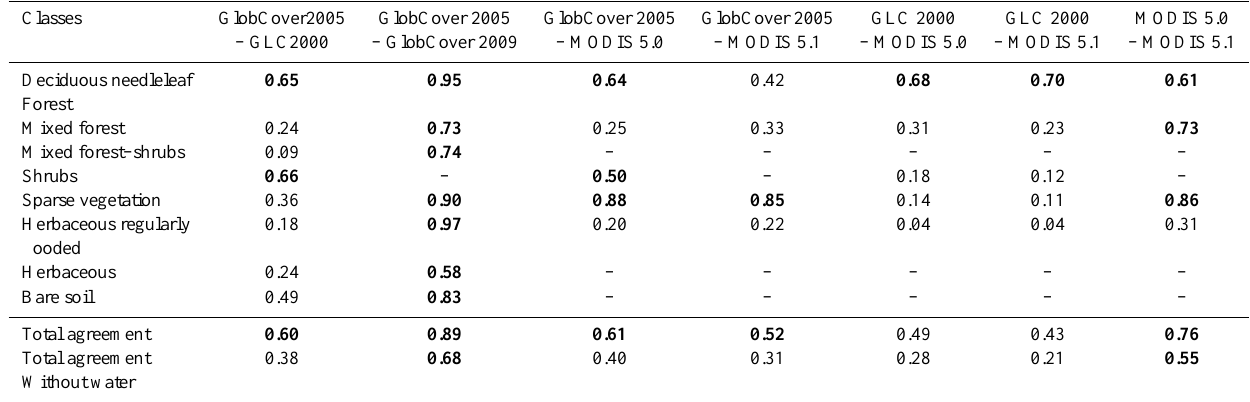
Table 5. Agreement percentages in Yakutia (for the main classes and comparison of GlobCover 2005 with GlobCover 2009, GLC